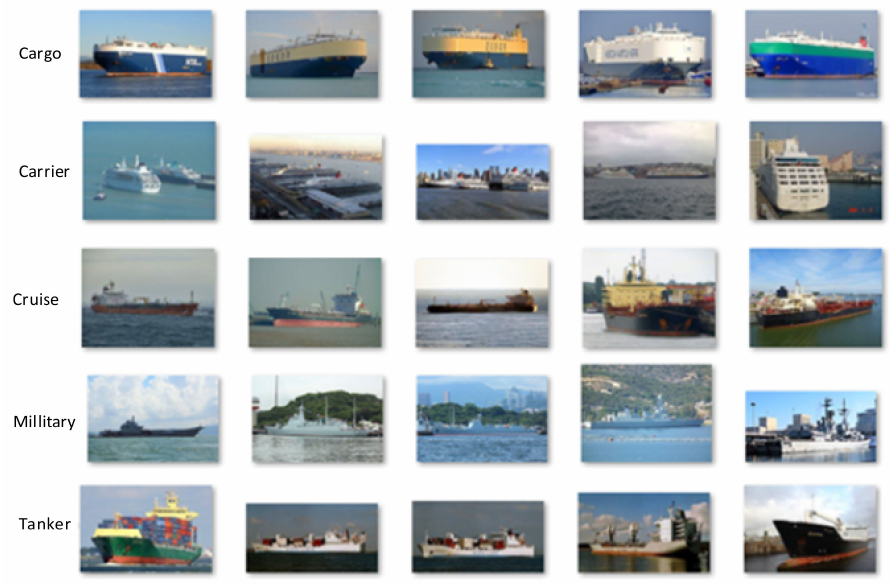
Figure 2. Random selected images from the